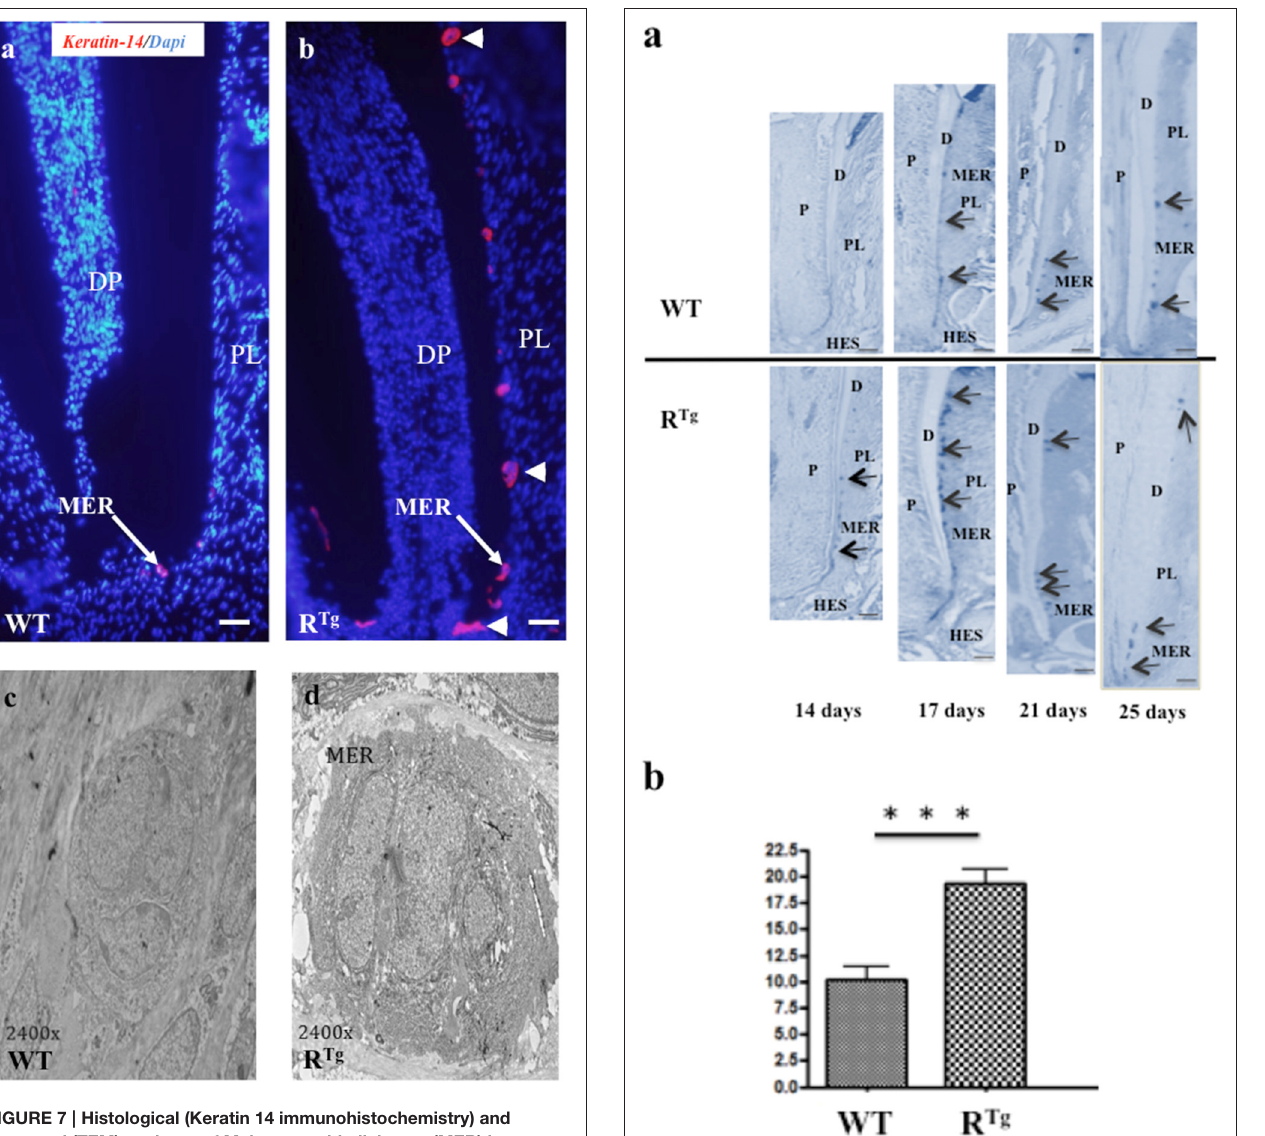
FIGURE 7 | Histological (Keratin 14 immunohistochemistry) and structural (TEM) analyses of Malassez epithelial rests (MER) in 25-day-old mice. A higher number of MER was observed in R Tg than WT mice (red staining in a,b ) with most appearing to be hyperplasic and/or hypertrophic (arrow-heads in b ). TEM analysis (c,d) showed that the hypertrophic appearance of MER was associated with an increased number of cells rather than a higher cell volume. DP, dental papilla; PL, periodontal ligament. Scale bars in a,b correspond to 50 µ m. TEM magnification is 2400 X. This increase was associated with the involvement of RANK in gingival epithelium homeostasis, as previously established for the epidermis (Duheron et al., 2011). Indeed, RANK is expressed by keratinocytes of the epidermal basal layer and is activated by RANKL. Moreover, the expression is much higher in supra-basal layer keratinocytes of R Tg than WT mice. In this transgenic mouse line, the hyper-proliferation of keratinocytes was shown to be independent of immune system activation, but instead a cell-autonomous process (Duheron et al., 2011).